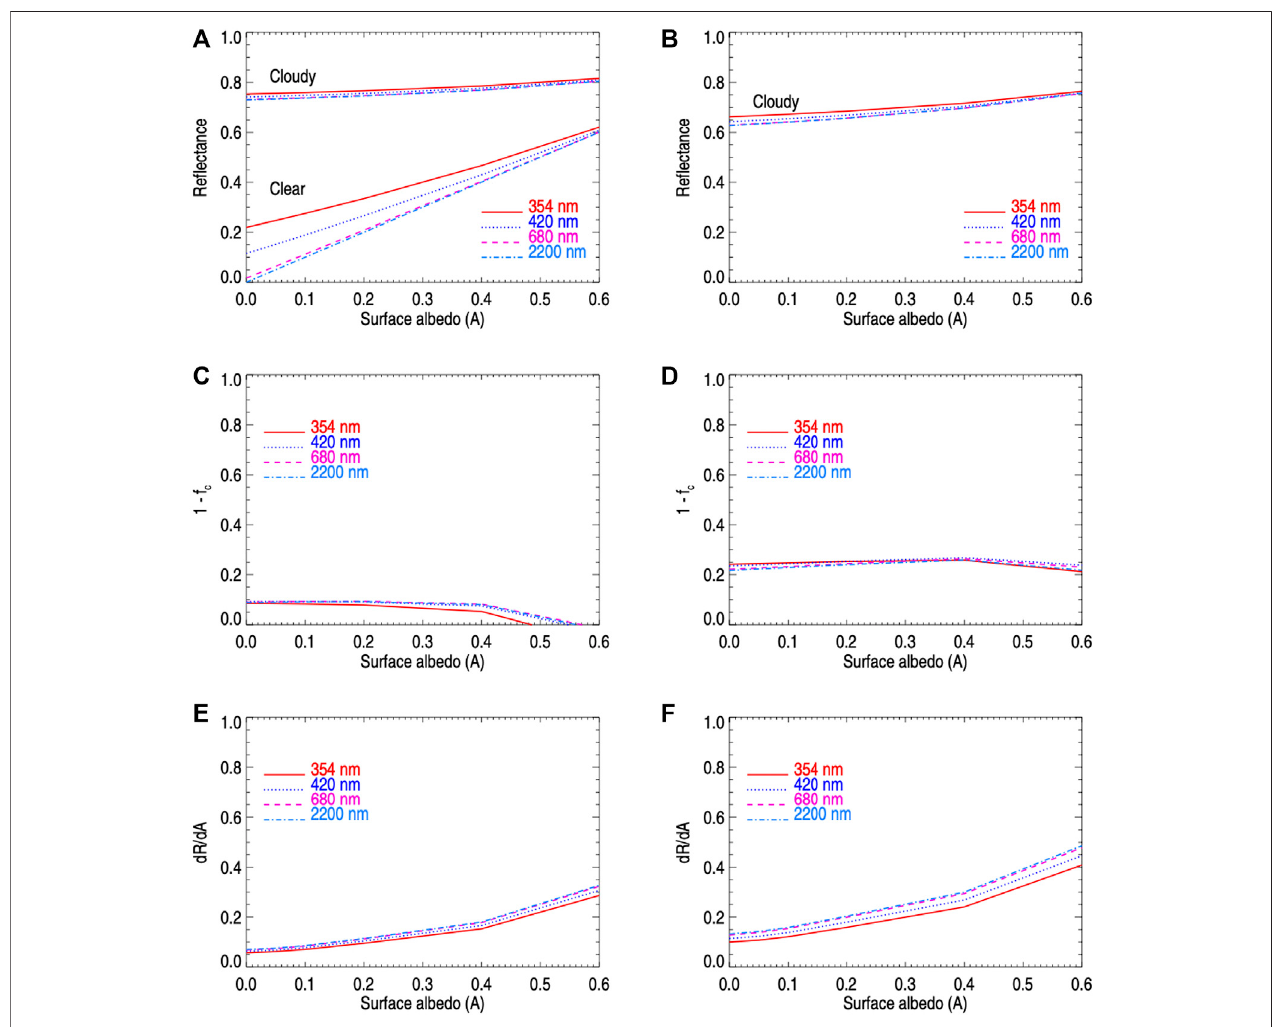
FIGURE 5 | Similar to Figure 4 but for cloud optical thickness of